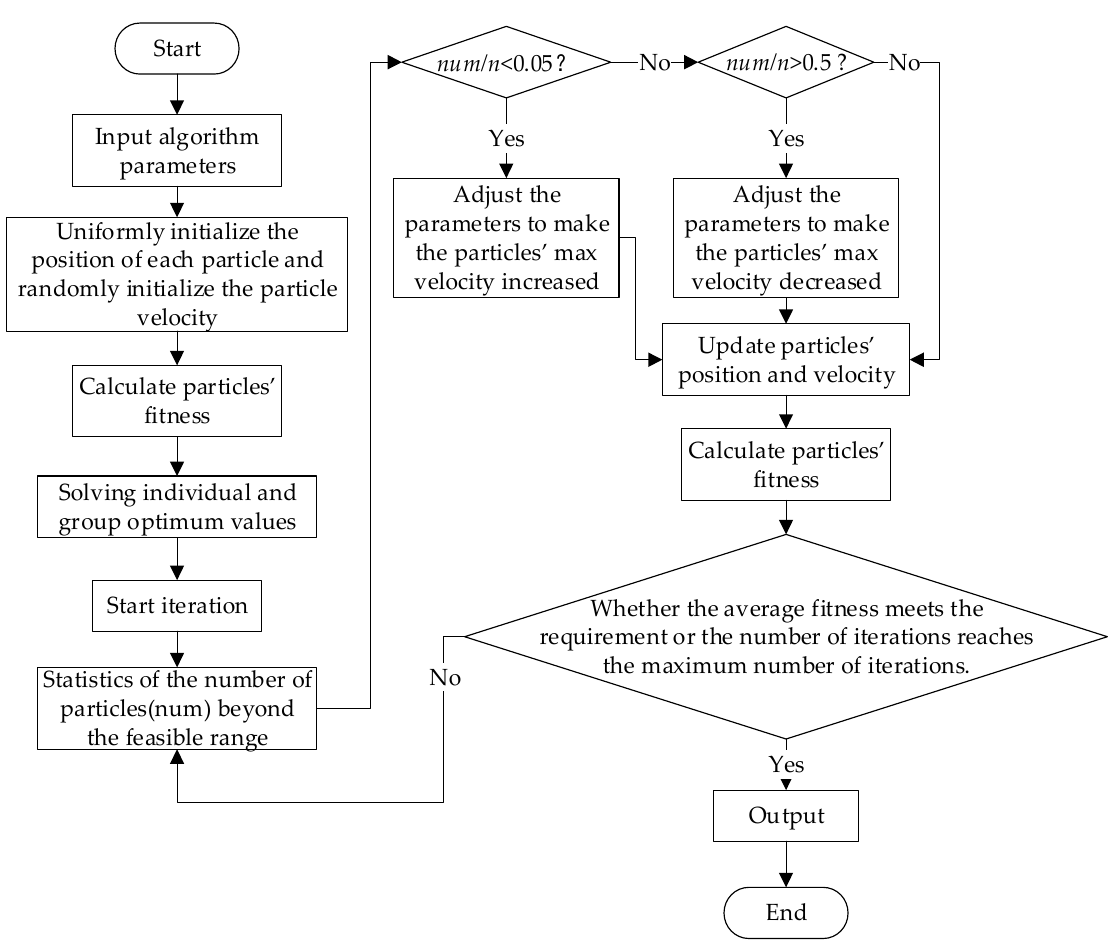
Figure 1. Flow chart of velocity-controlled particle swarm optimization (VCPSO) algorithm .